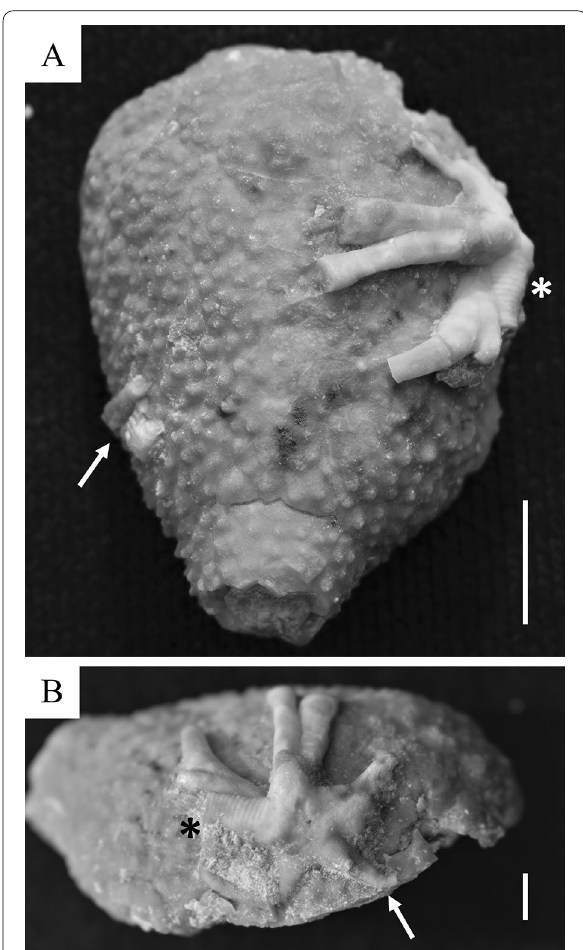
Fig. 2 Theca of the holocystitid diploporitan Holocystites scutellatus from the same locality and stratigraphic interval as that in Fig. 1. This specimen (CMC IP 88497) is also encrusted by a large Eucalyptocrinites radicular attachment structure. A View of the lateral surface of the diploporitan theca with the encrusting crinoid attachment structure along the thecal margin to the right side of the image. The arrow marks the disconnected radice segments that probably represent the maximum length of radices. The asterisk marks a prominently multi-plated radice. Scale bar 10 mm. B Close-up of the attachment = structure, showing the multitude of radices, their radial orientation and their multi-plated composition were not covered by a cortex. Note that the radices extending toward the central portion of the theca are long and well developed, whereas those extending farther outward toward the thecal margin are short, with one displaying a sharp change in direction, marked by the arrow, to run along the outermost edge of the theca. The asterisk marks the same multi-plated radice shown in A . Scale bar 2 =